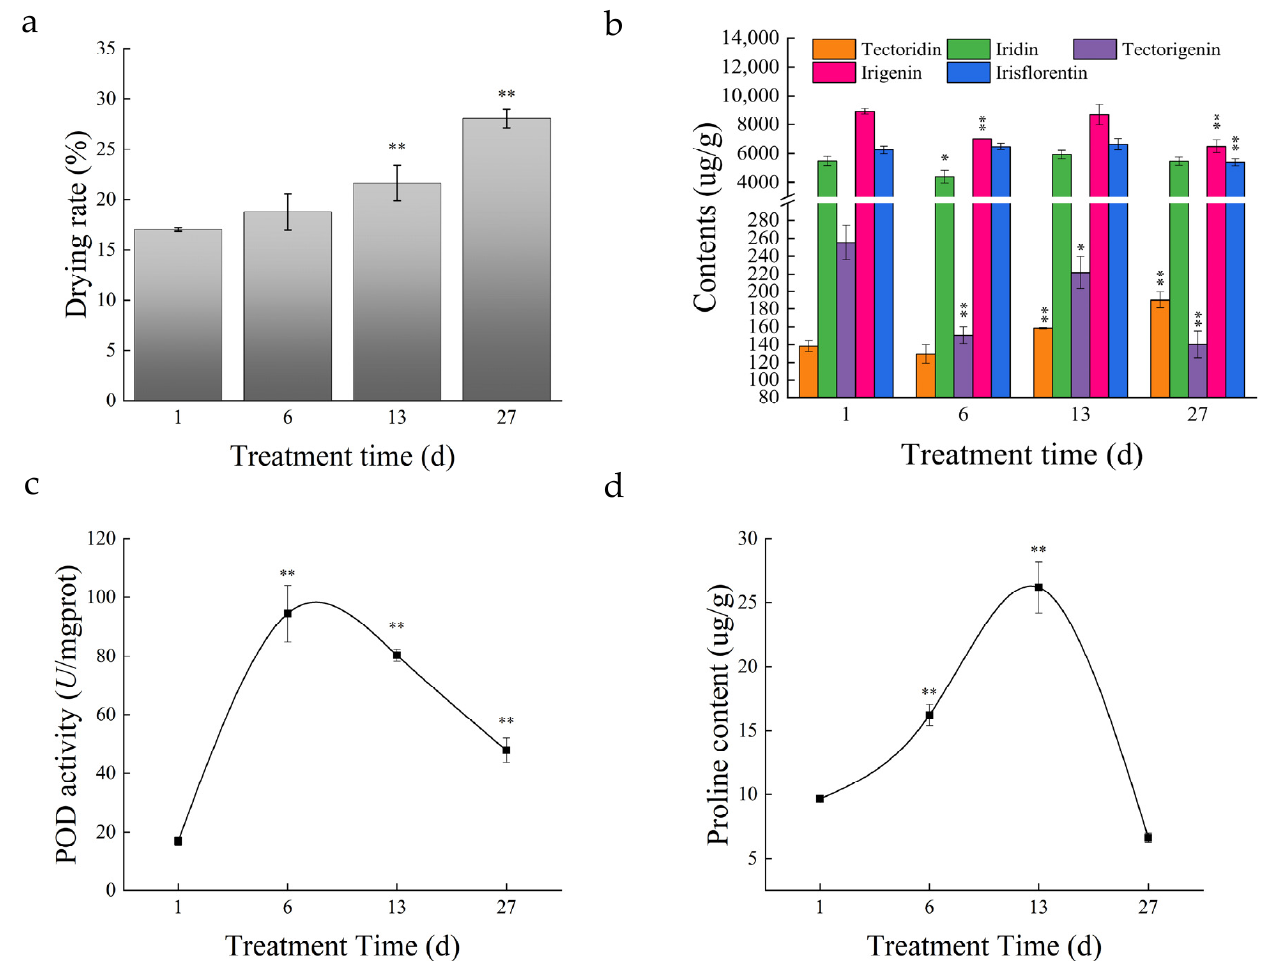
Figure 2. Drying rate (the ratio of dry weight to fresh weight) ( a ), isoflavone contents ( b ), POD activities ( c ), and Proline ( d ) of roots in I. domestica (* indicates a significant correlation at the 0.05 level, ** indicates a significant correlation at the 0.01